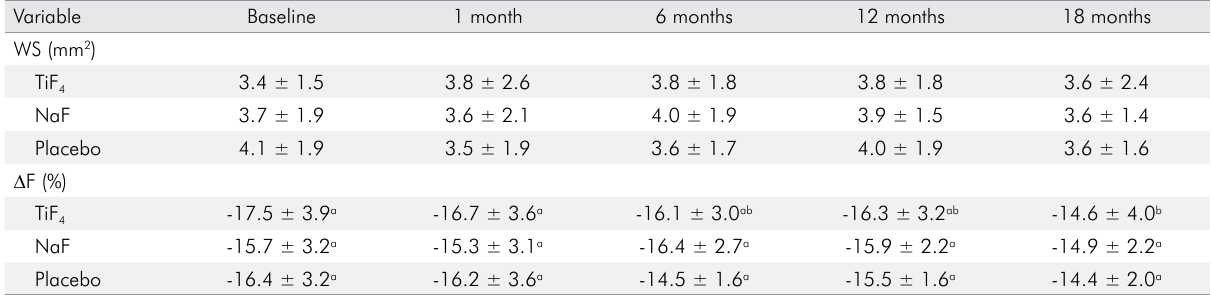
Table 2. Mean ± S.D. of the data obtained by QLF at baseline and after 1, 6, 12 and 18 months of treatment with TiF placebo varnish.